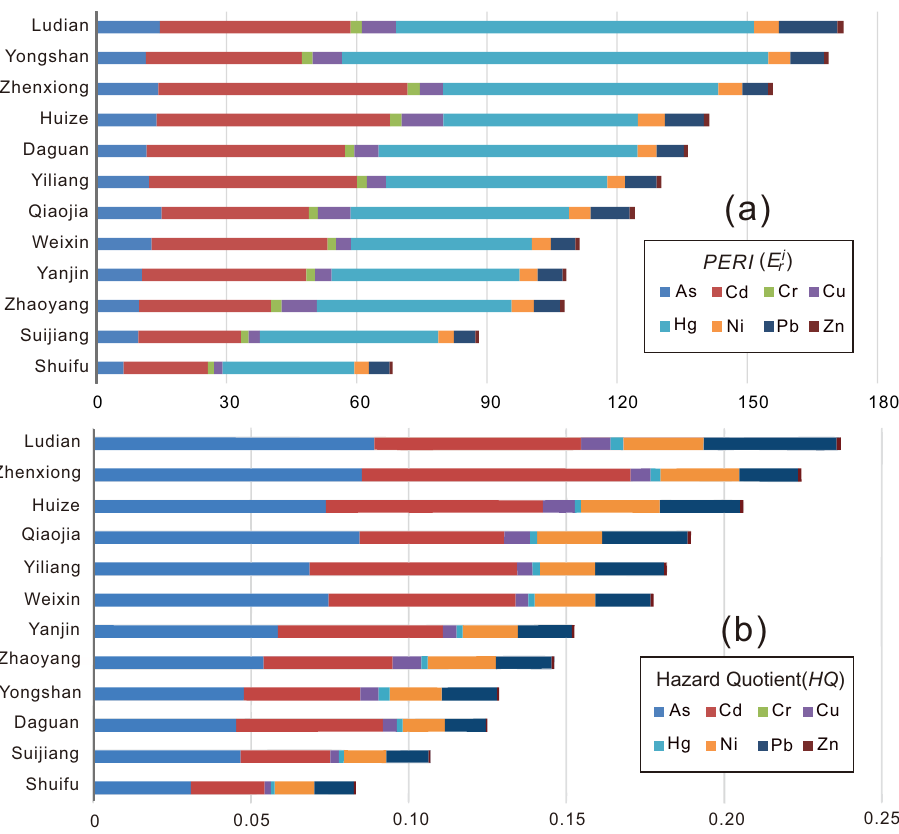
Figure 4. Average values of the potential ecological risk index ( E i r ) ( a ) and hazard quotient ( HQ ) ( b ) of heavy metals in the study area.